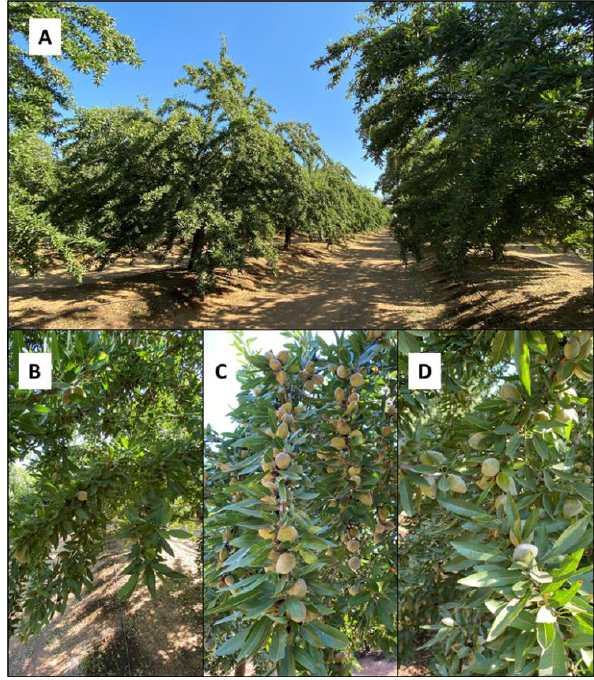
Figure 1. Experimental almond orchard ( A ) and cvs. Marta ( B ), Guara ( C ) and Lauranne ( D ).